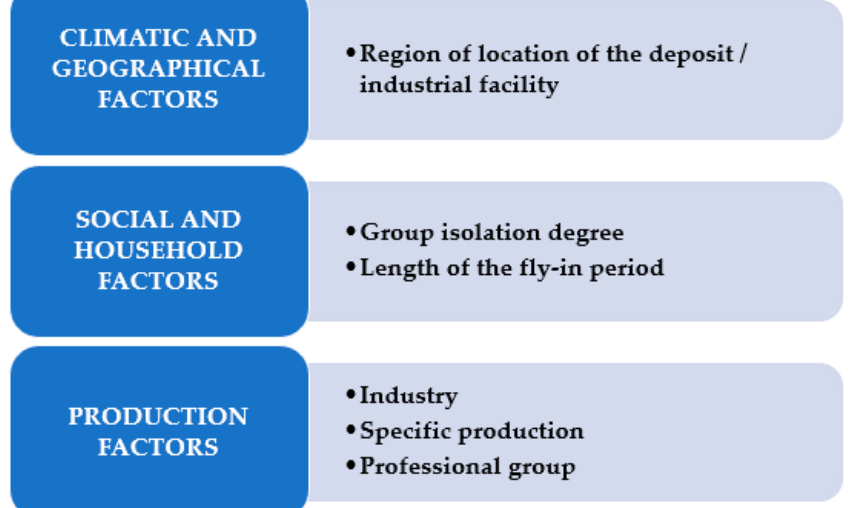
Figure 2. Levels of differential analysis of professional activity for FIFO method of labor organiza ‐ tion.